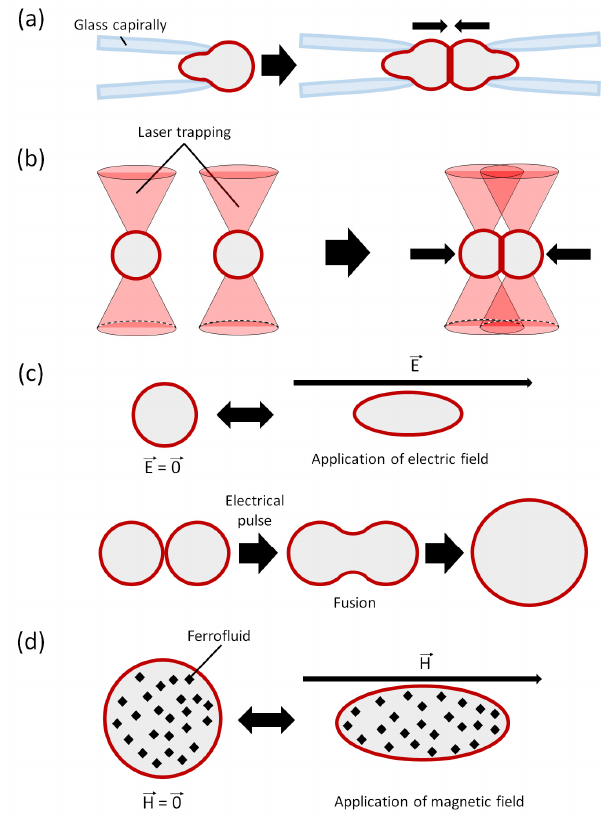
Figure 4. Schematic illustration of manipulation of GVs by ( a ) glass capillary (micropipette), ( b ) optical tweezers, ( c ) electric field, and ( d ) magnetic field (for GVs encapsulating ferrofluid).